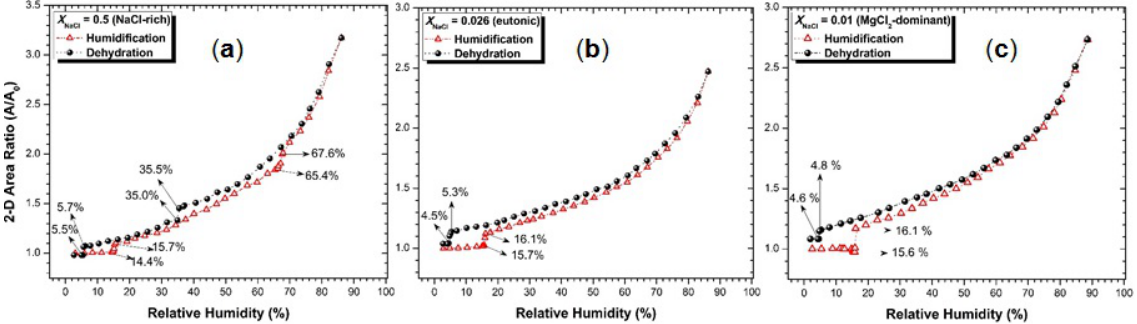
Figure 4. Plots of 2-D area ratio ( A / A 0 ) of NaCl–MgCl 2 mixture aerosol particles with (a) a NaCl-rich mixing ratio of X NaCl = 0.5; (b) a MgCl 2 -dominant eutonic composition of X NaCl = 0.026; and (c) a MgCl 2 -dominant mixing ratio of X NaCl = 0.01 as a function of RH. The recorded transition relative humidities in both humidification and dehydration processes are marked with arrows.